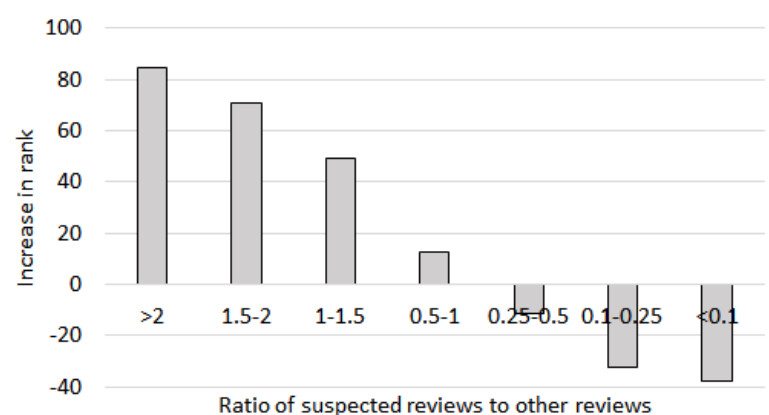
Fig. 3. Average increase in the room ranking given the ratio of suspected